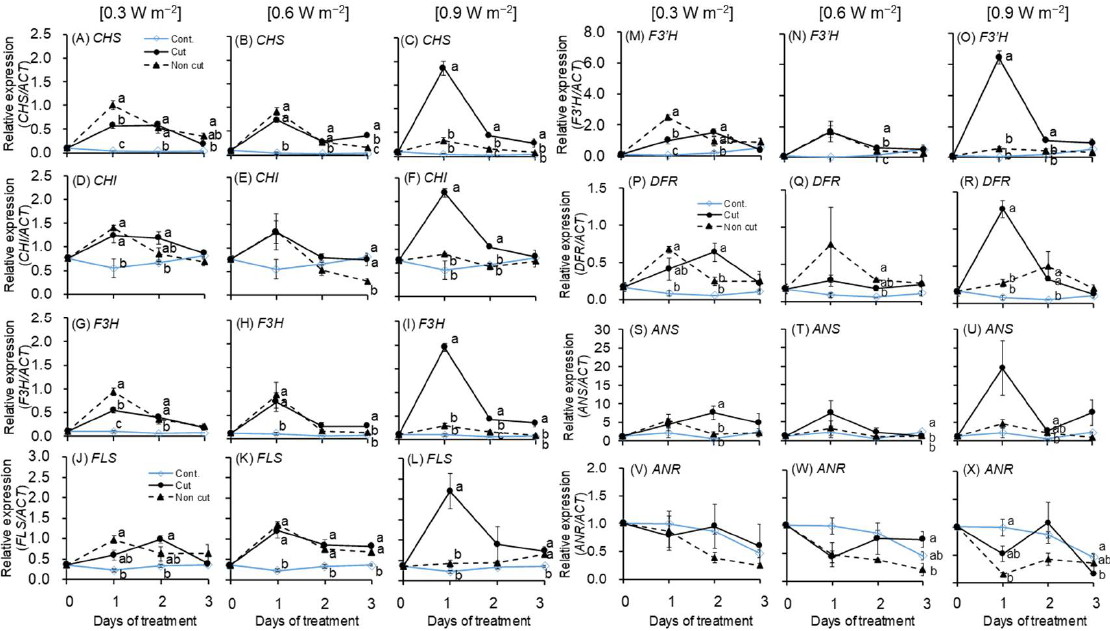
Figure 6. Gene expression of PAL ( A – C ); C4H ( D – F ); 4CL ( G – I ); FLS ( J – L ); F3’H ( M – O ); DFR ( P – R ); ANS ( S – U ); ANR ( V – X ) mRNA in the third leaf ( n = 3). UV irradiation intensities were set at 0.3, 0.6, and 0.9 W m −2 . The vertical bars indicate SE ( n = 3). Different letters indicate significant differences among treatments in each UV irradiation intensity at p < 0.05 by Tukey–Kramer’s test.